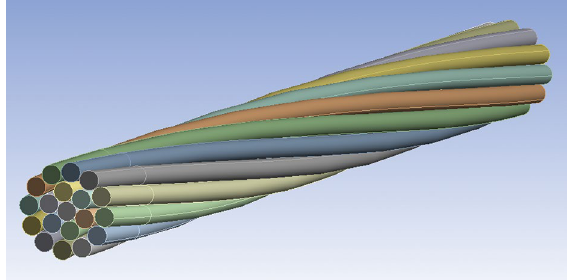
Fig. 3. 1 × 19 stainless steel core